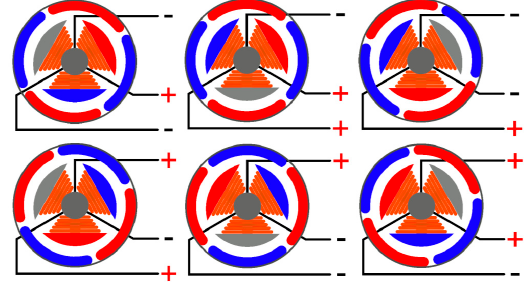
Figure 1. Schematic of the operation of a brushless direct current (DC) motor.